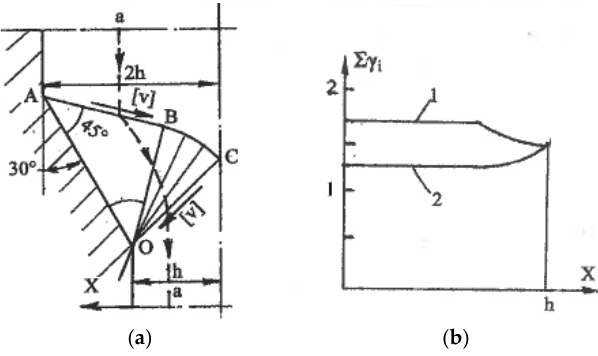
Figure 10. Simple shear processing during extrusion: ( a ) slip line field for extrusion through smooth 30° die with an area reduction of 50%; ( b ) distribution of accumulated shear (1) and shears along lines of velocity discontinuity (2) through section h.